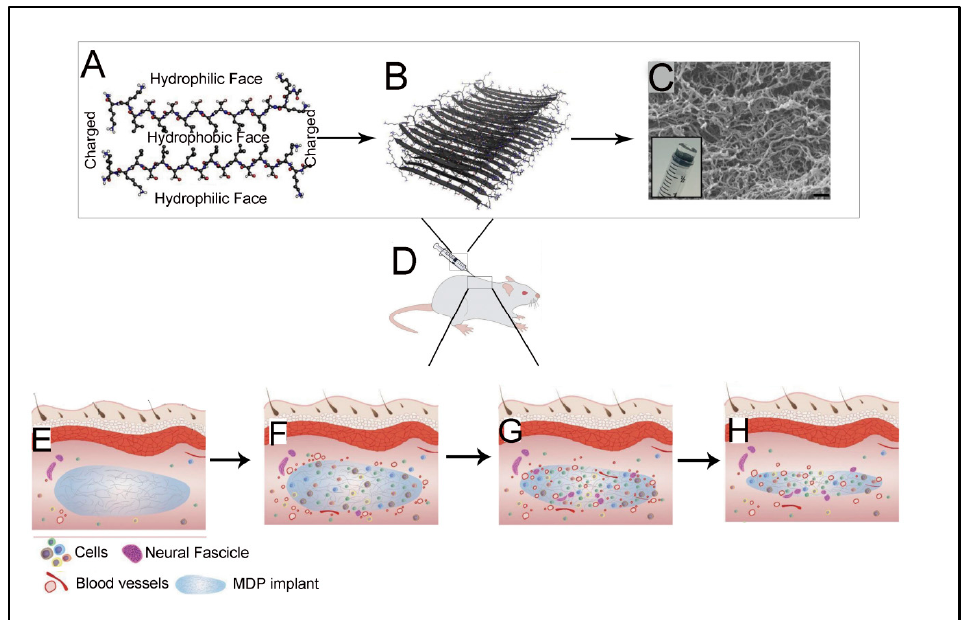
Figure 16. Angiogenesis and neurogenesis elicitation by nanofibrous peptide hydrogel. ( A ) A dimer of K 2 (SL) 6 K 2 peptides represents a hydrophobic sandwich; ( B ) Nanofiber formation by self-assembled K 2 (SL) 6 K 2 peptides; ( C ) SEM representation of the K 2 (SL) 6 K 2 hydrogel (Scale bar: 200 nm); ( D ) Schematic illustration of hydrogel injection into dorsal tissue; ( E – H ) Hydrogel remod- eling representation during six weeks initiated with cell infiltration followed by angiogenesis and innervations and finishing with slow biodegradation. Reprinted with permission from Ref. [293], Copyright 2018,